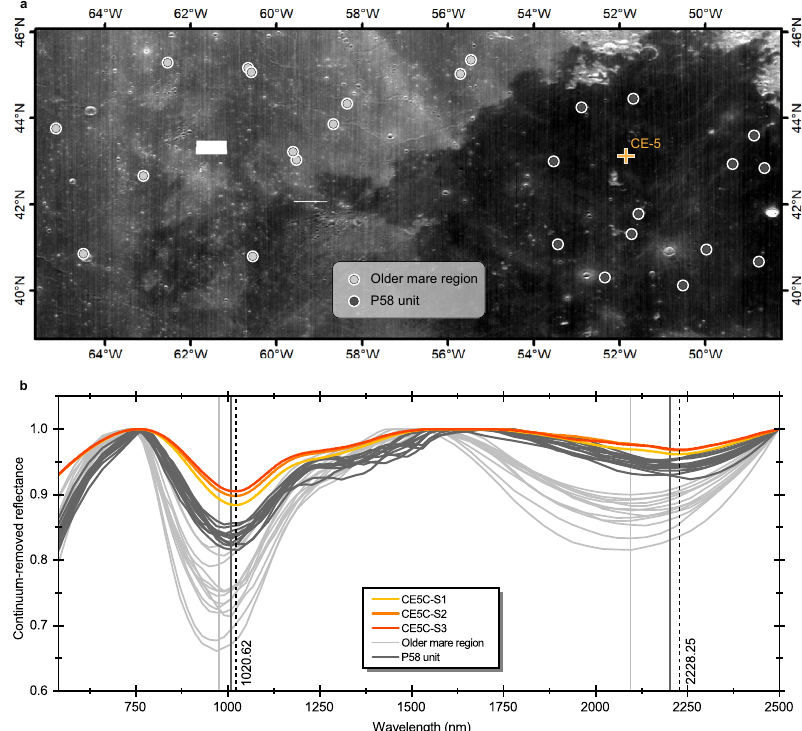
Fig.6|SpectralcomparisonoftheCE-5soilsampleswithP58unitandadjacent older mareregion. a Location of the fresh cratersselected for spectralextraction. The base map is Moon Mineralogy Mapper (M 3 ) 1508nm re fl ectance map. b Continuum-removed spectra of CE-5 samples and spectra from P58 unit and adjacentoldermareregion.Verticaldashedlinesindicatethemeanbandcentersof CE-5 samples, and vertical gray solid lines refer to mean band centers of P58 unit